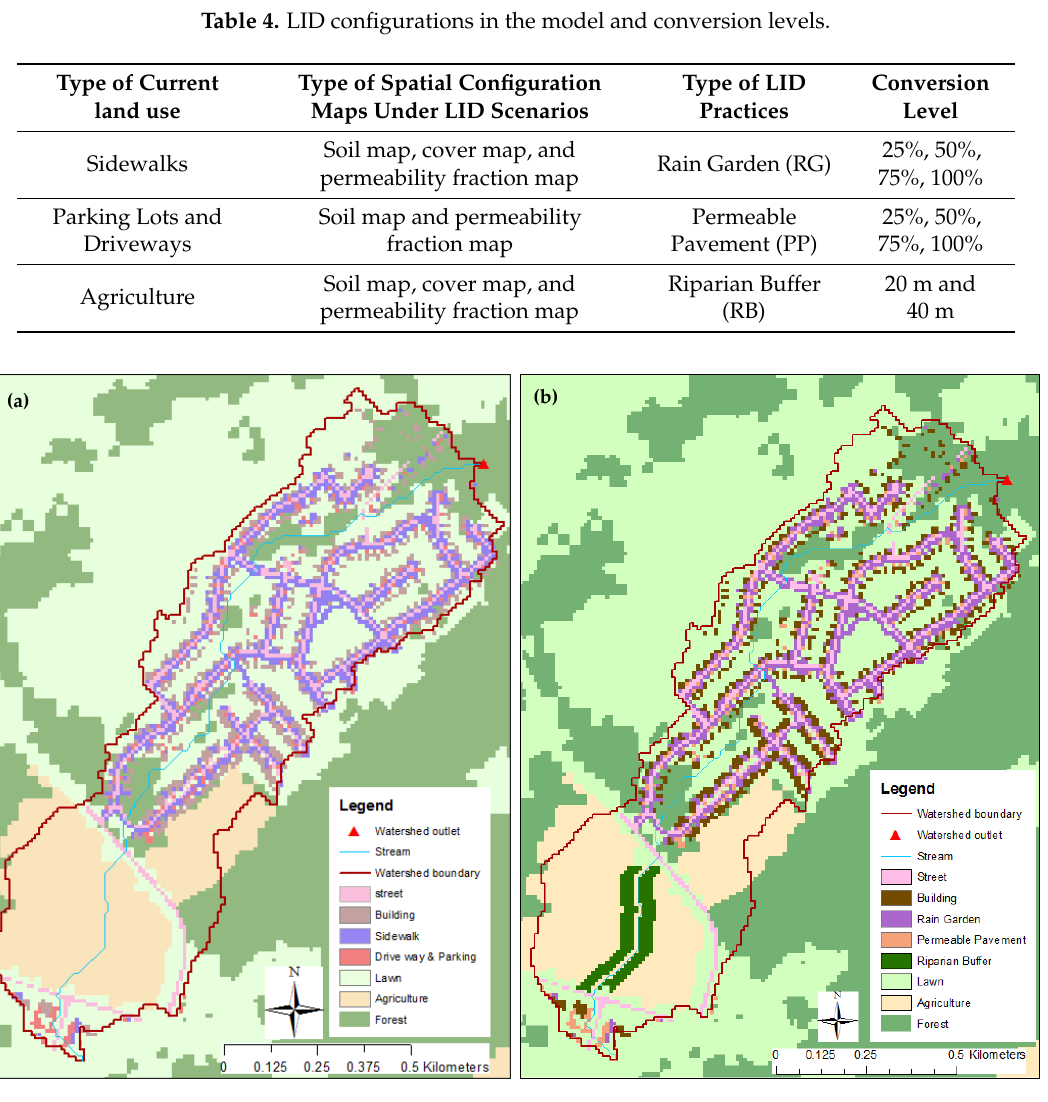
Figure 3. The spatial configuration of different land covers in the SHC watershed, with 10m cell resolution: ( a ) Current land cover, and ( b ) after LID implementation: Conversion of a 100% spatial configuration of the sidewalks to rain gardens, and driveways and parking lots into permeable pavements, and the implementation of 40 m forest buffers along both sides of the stream on the agricultural land. The watershed outlet is identified as a red